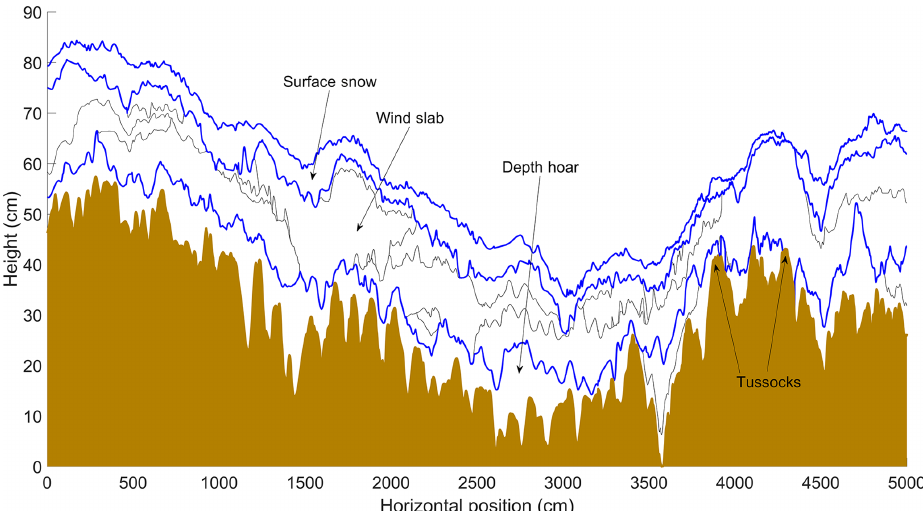
Figure 6. Cross section with vertical exaggeration of layer boundaries of individual stratigraphic layers in trench 4 (50m). Blue lines highlight boundaries between snow and air, surface snow and wind slab, and wind slab and depth hoar. The brown area is subnivean soil or vegetation (two tussocks are labelled). Black lines show boundaries of individual layers aggregated within the wind slab and depth hoar layers.